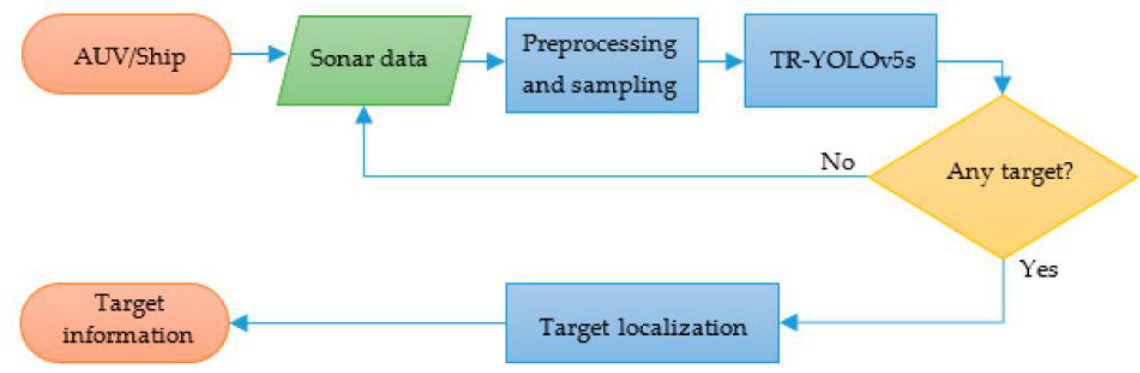
Figure 1. The flow chart of the proposed real-time SSS ATR